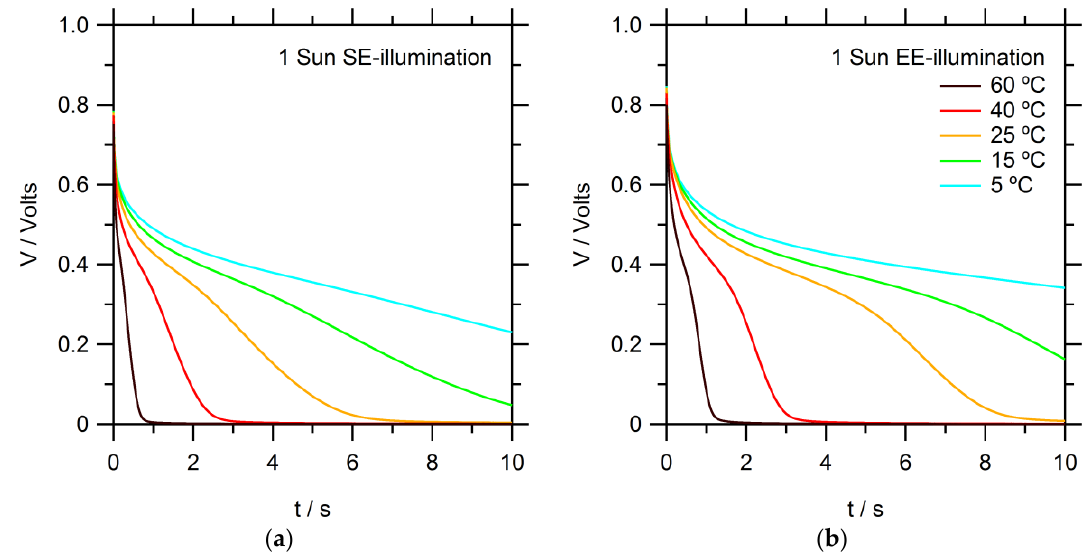
Figure 4. Open-circuit voltage decay of a DSSC with Co(bpy) 3 /TPAA/MPN electrolyte in the dark after an illumination period of 10 s at 1 sun, comparing ( a ) SE- and ( b ) EE- illumination.